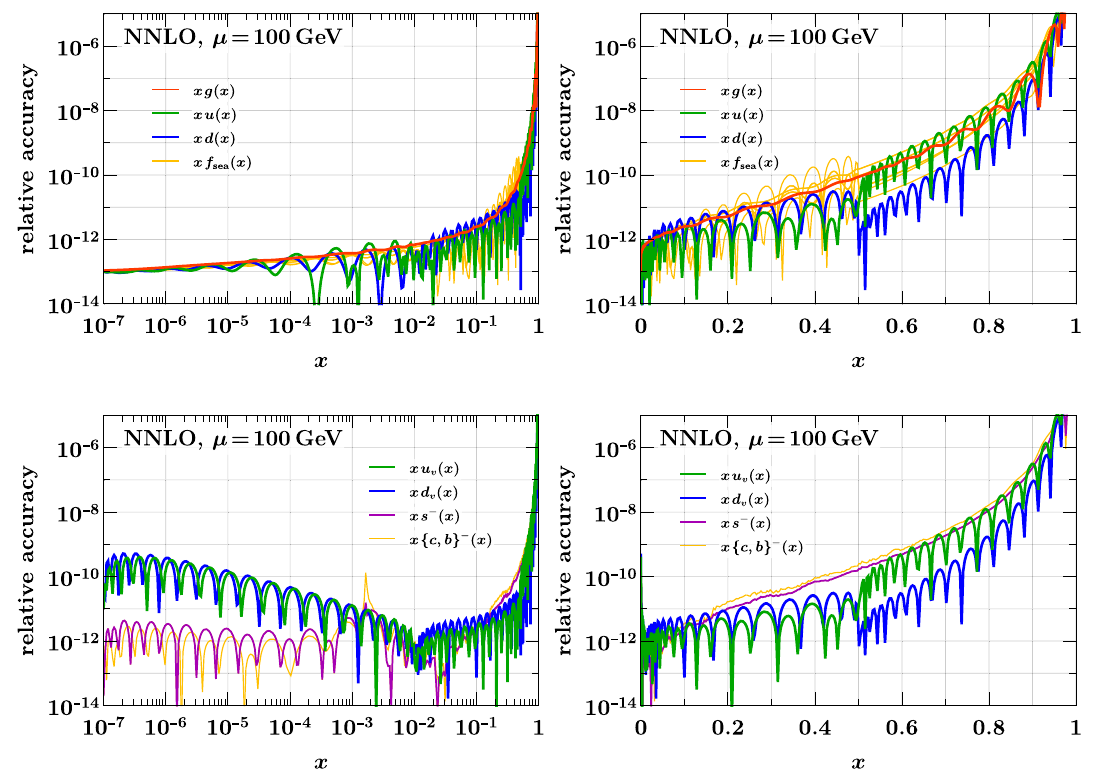
Fig. 11 Relative numerical accuracy of NNLO DGLAP evolution and row shows quark, antiquark, and gluon distributions (with f sea ∈ √ {¯ u , ¯ d , s , ¯ s , c , ¯ c , b , ¯ b } ), and the bottom row shows the differences q − ¯ flavor matching from μ 0 = 2 GeV and n F = 3 to μ = 100GeV and n F = 5. We use the PDFs defined in Refs. [73,74]. The top